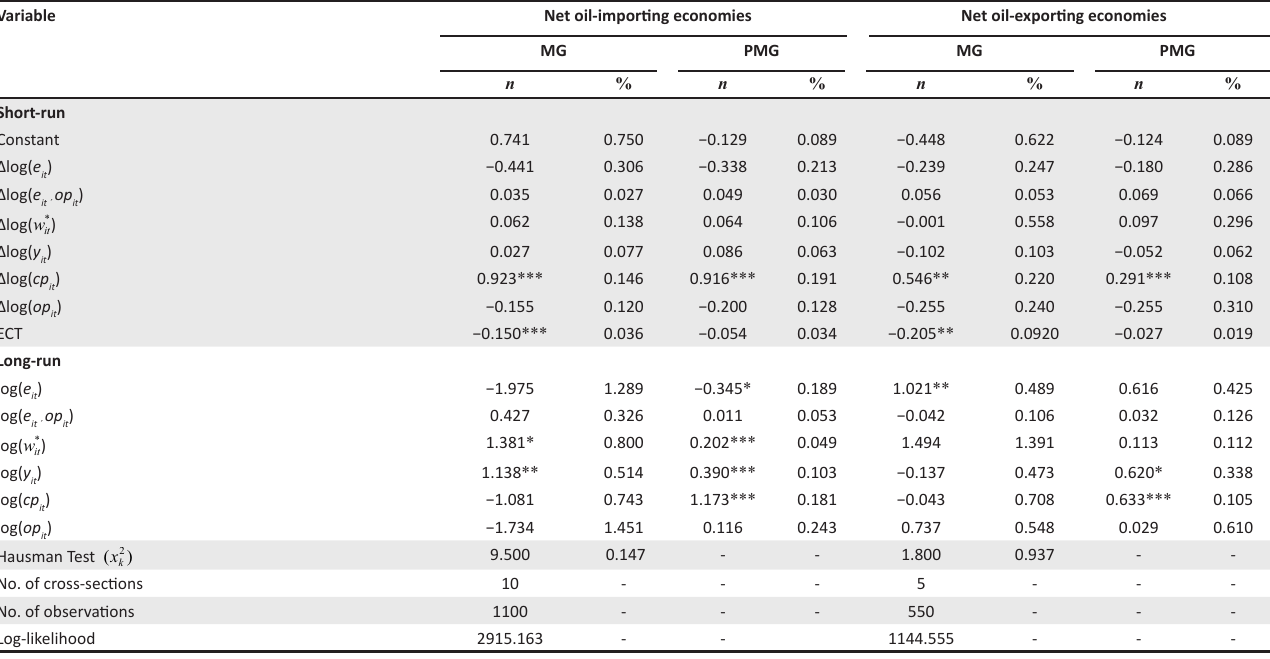
TABLE 3: Exchange rate pass-through panel regression results (symmetric model with interaction term). Variable